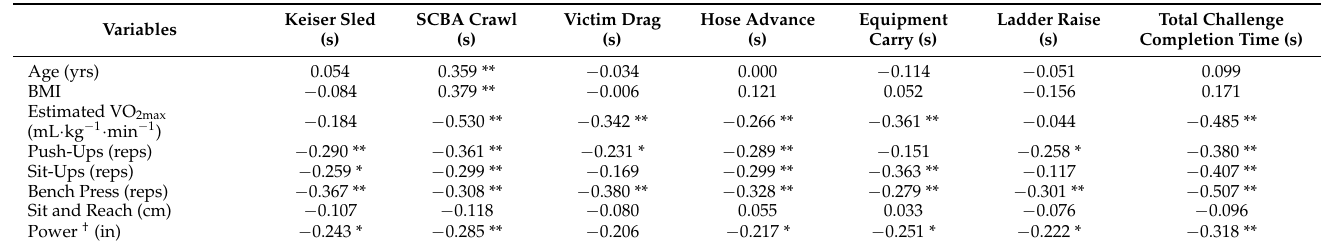
Table 5. Correlations between Fitness and Firefighting Ability at Week 1.